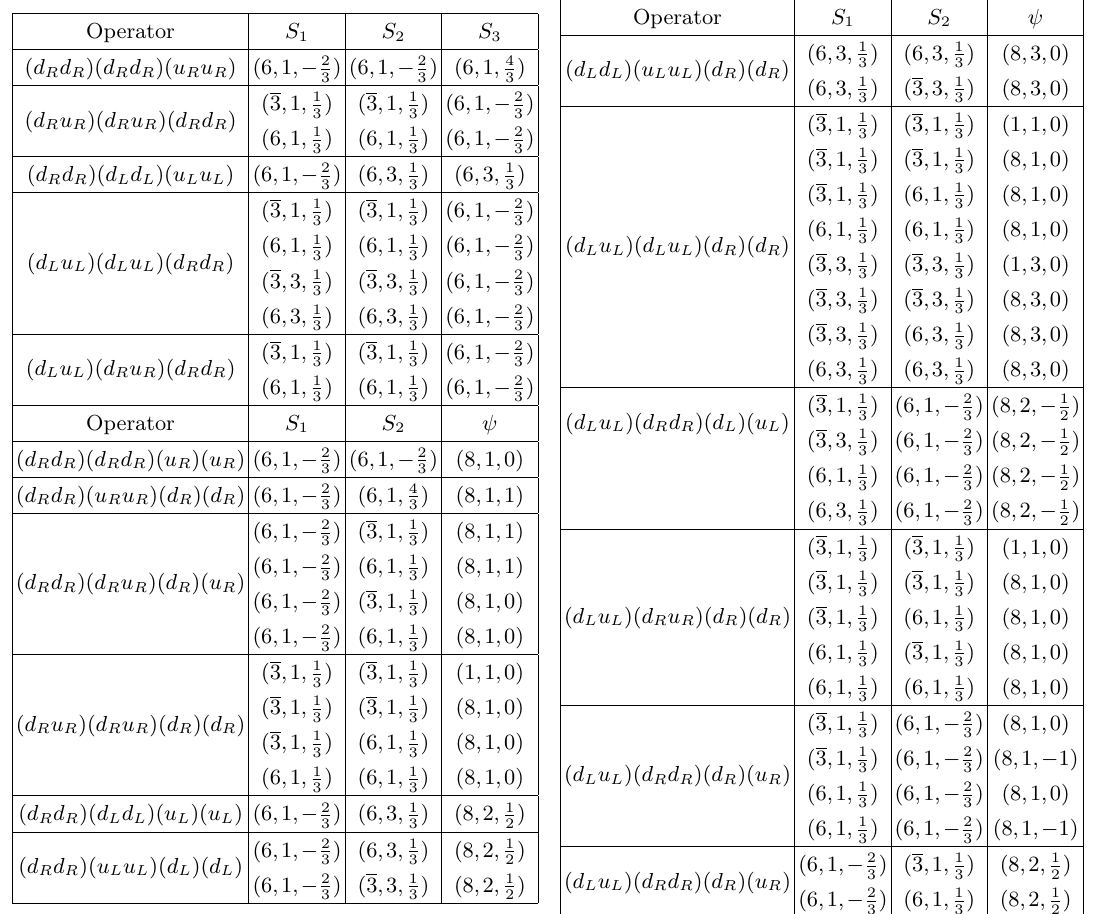
Table 3 . The decomposition of n − n operators at tree